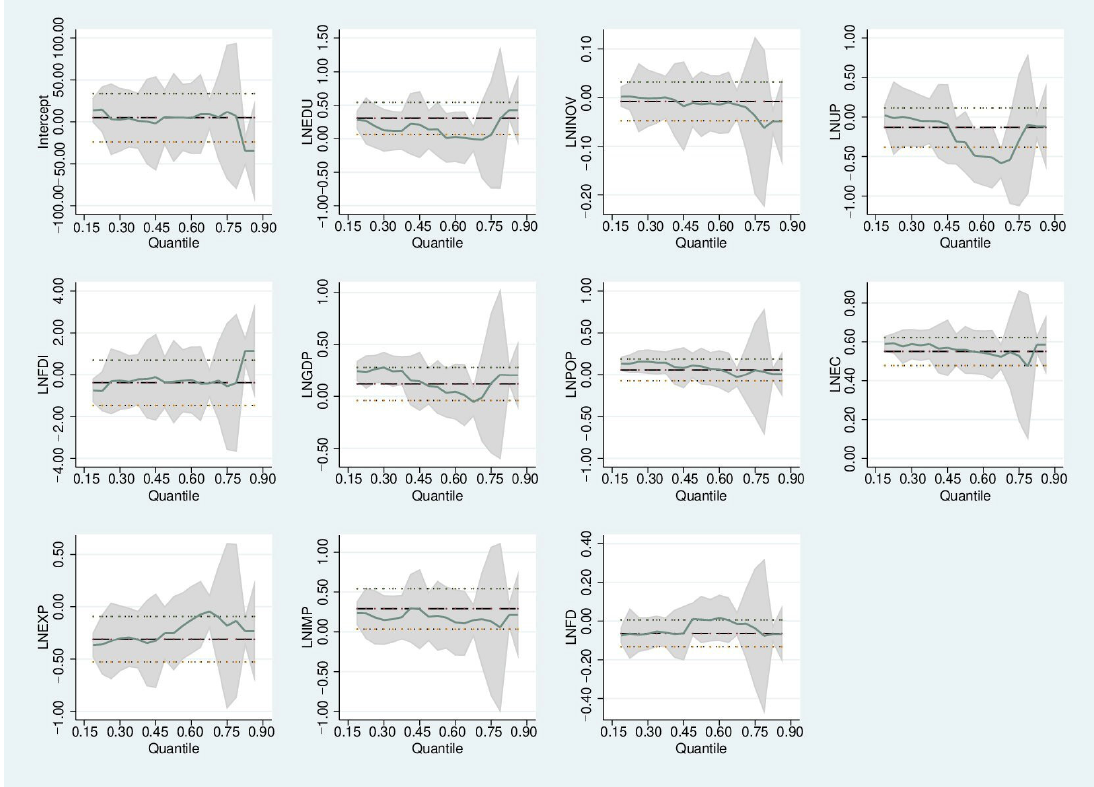
Figure 2. Quantile Distribution for Upper-Middle-Income Countries.